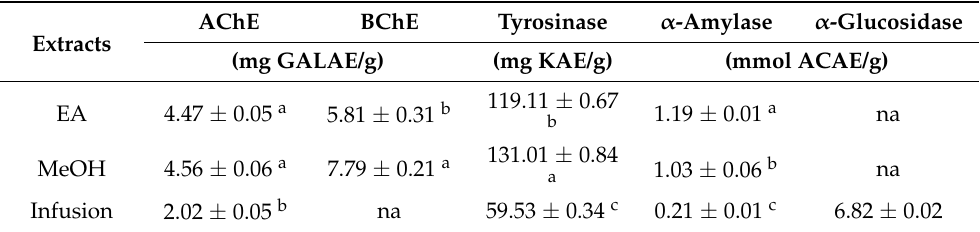
Table 4. Enzyme inhibitory properties of the tested extracts. AChE BChE Tyrosinase α -Amylase α -Glucosidase Extracts